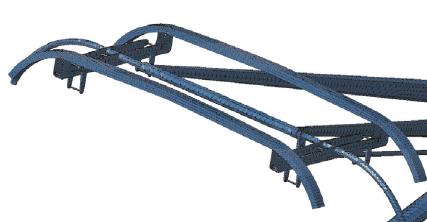
Figure 14: Acoustic meshes of pantographs in high-speed trains.